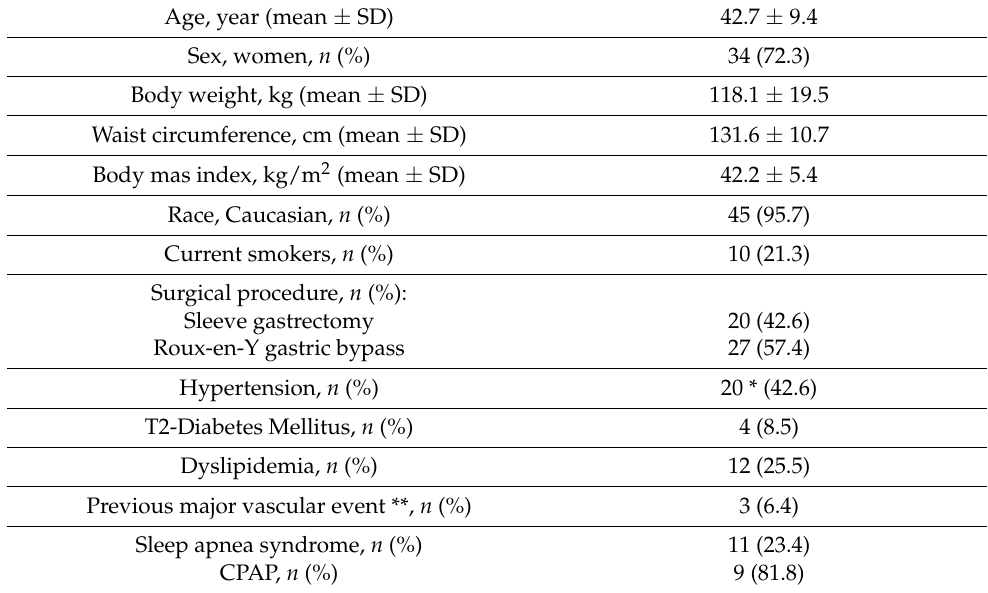
Table 1. Baseline clinical